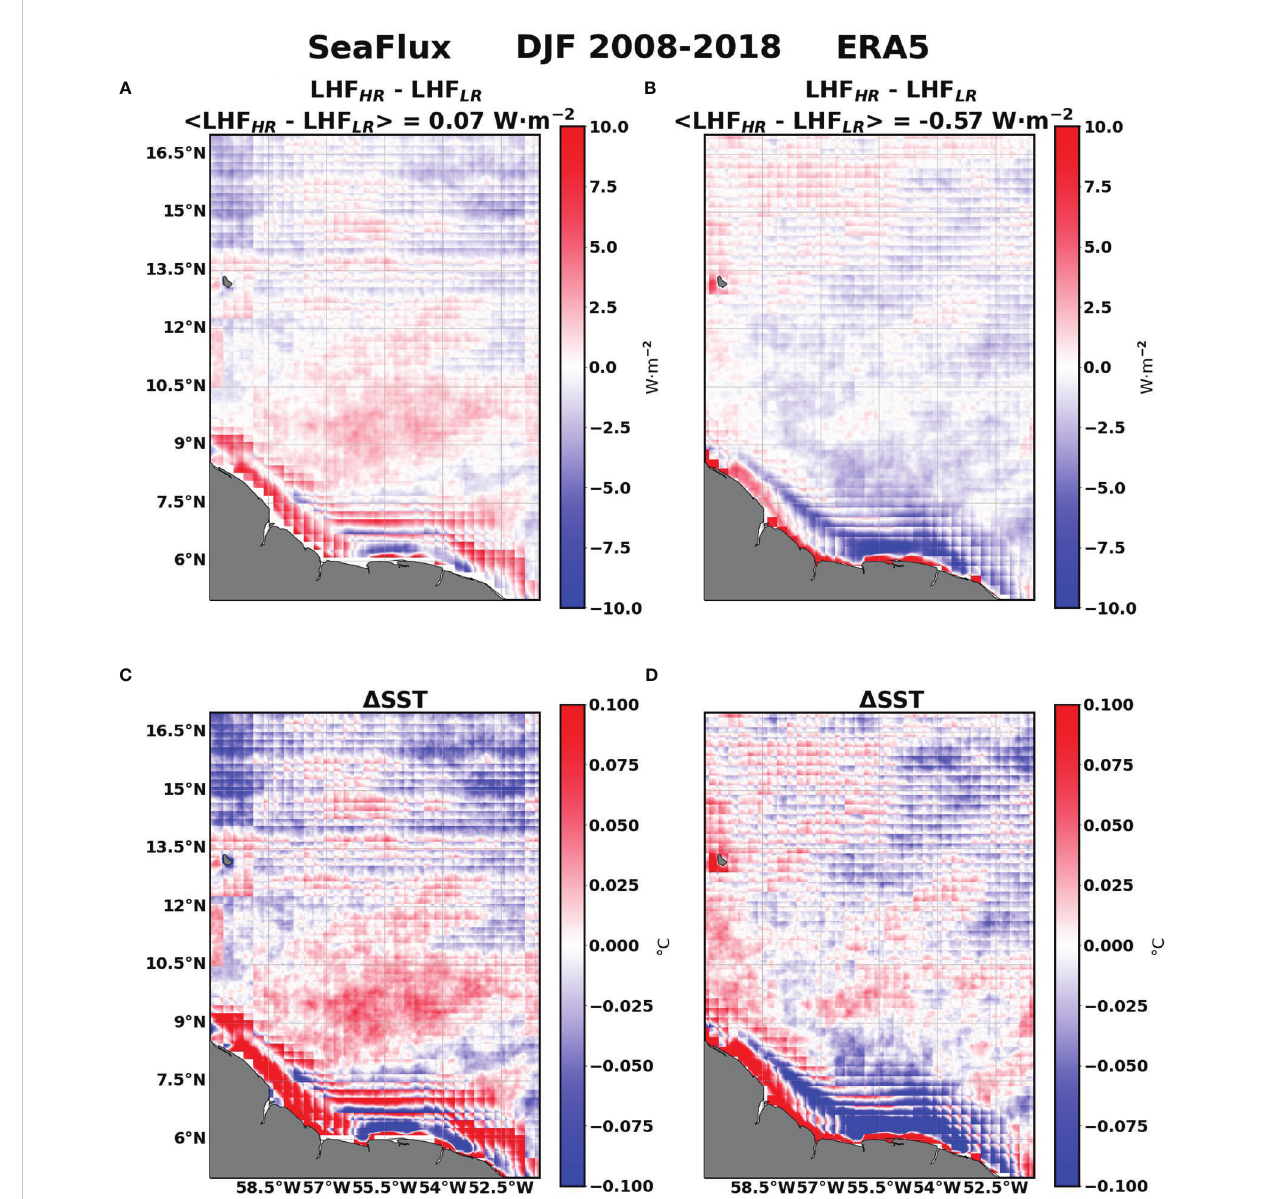
FIGURE 5 2008-2018 DJF mean of (A, B) difference between the reconstructed LHF from the downscaled near-surface variables and SST (LHF HR ) and the LHF obtained from the raw SeaFlux/ERA5 variables (LHF LR ). (C, D) represent the 2008-2018 DJF mean of the SST correction ( D SST) for SeaFlux/ERA5. Angle brackets in the titles of the fi gures represent the area-weighted mean values of the variables represented on the corresponding